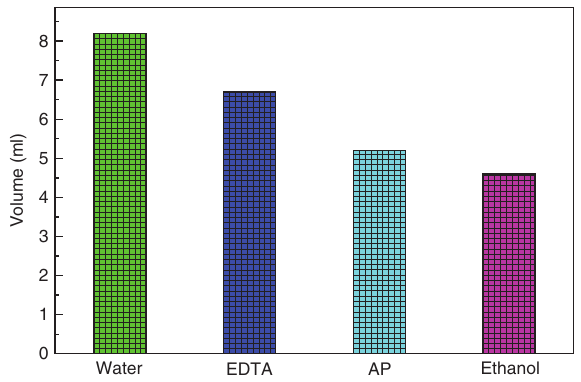
Figure 5: RSV of MgO slurry at different conditions.